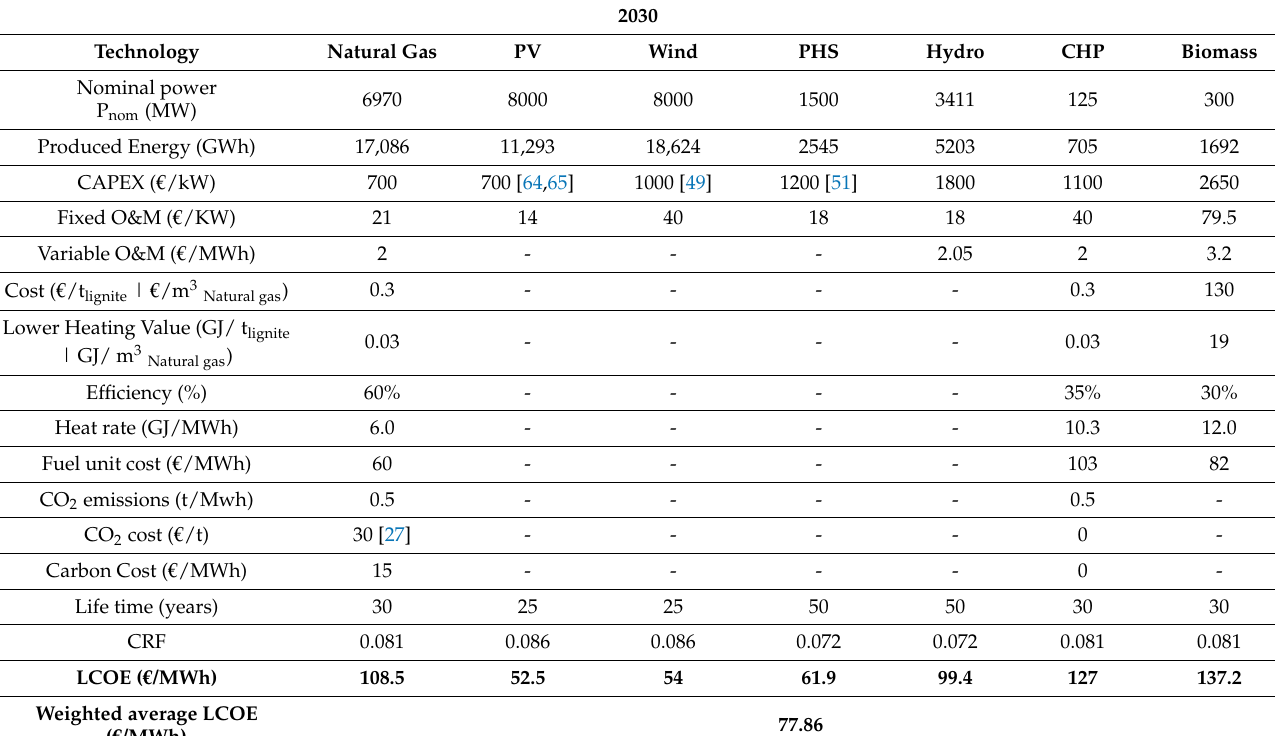
Table 5. Data used for LCOE calculation for